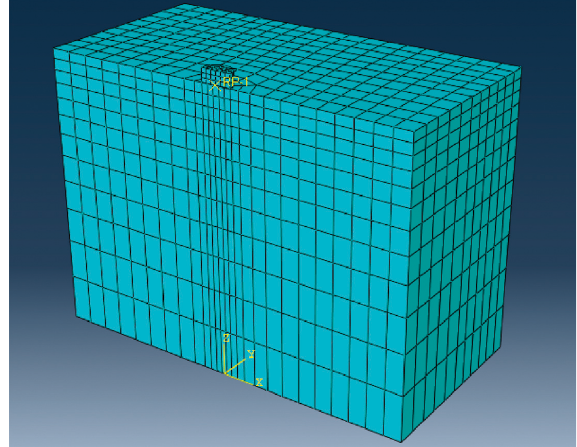
Figure 5: Three-dimensional numerical model diagram. Table 1: The physical and mechanical parameters of the